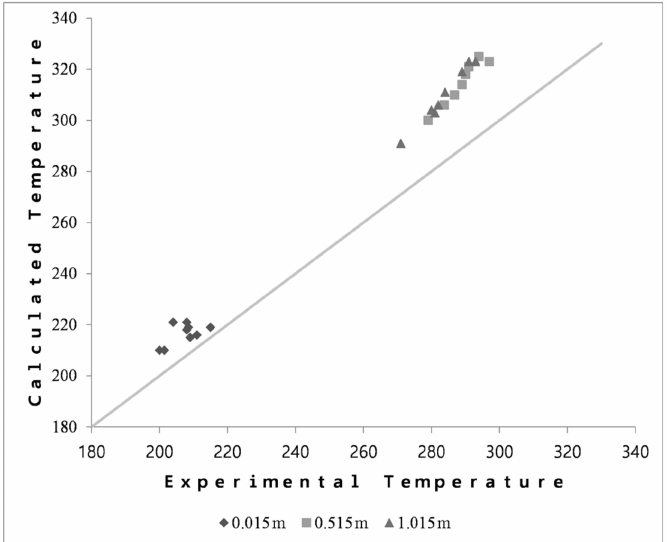
Figure 3. Calculated temperature and experimental temperature at 3 points (0.015 m, 0.515 m, and 1.015